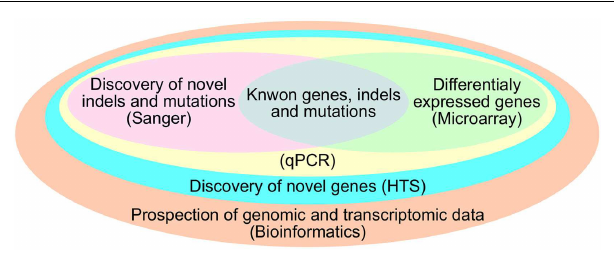
FIGURE 2 |Advantages of Bioinformatics and HTS over other